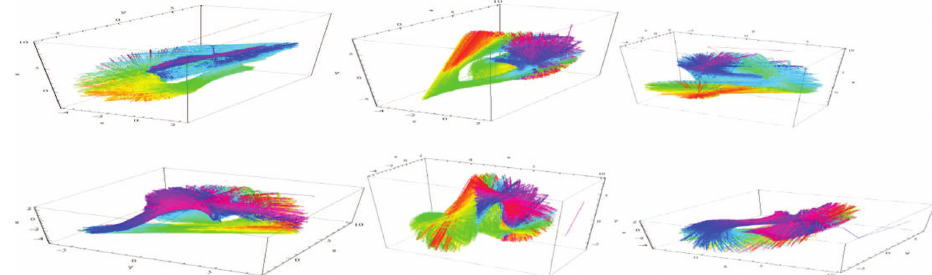
Figure 5: Chaotic Attractors of a Novel System, Three-Dimensional View.